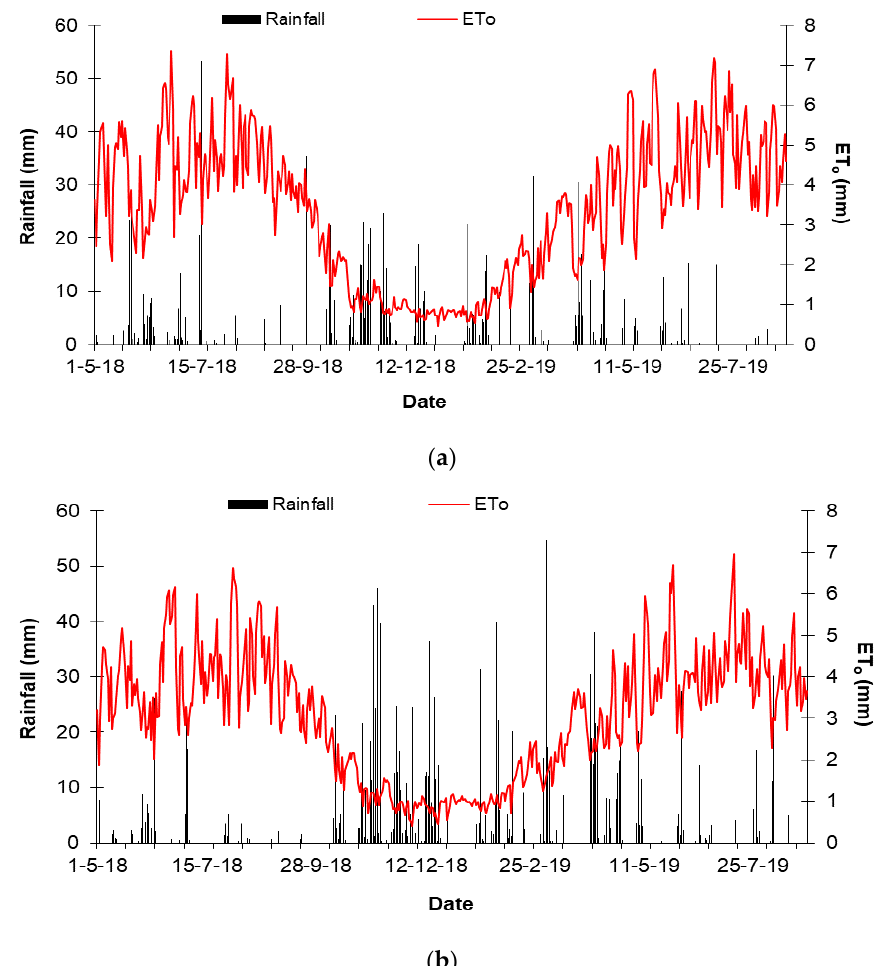
Figure 2. Dynamics of daily rainfall and reference evapotranspiration (ET o ) over the study period (May 2018–August 2019) for ( a ) “Ponte da Boga” in Ribeira Sacra; ( b ) “Tremoedo” in Rías Baixas weather stations.